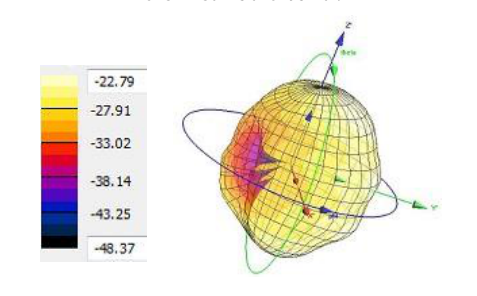
Figure 7. Radiation (3-D far field radiation pattern)